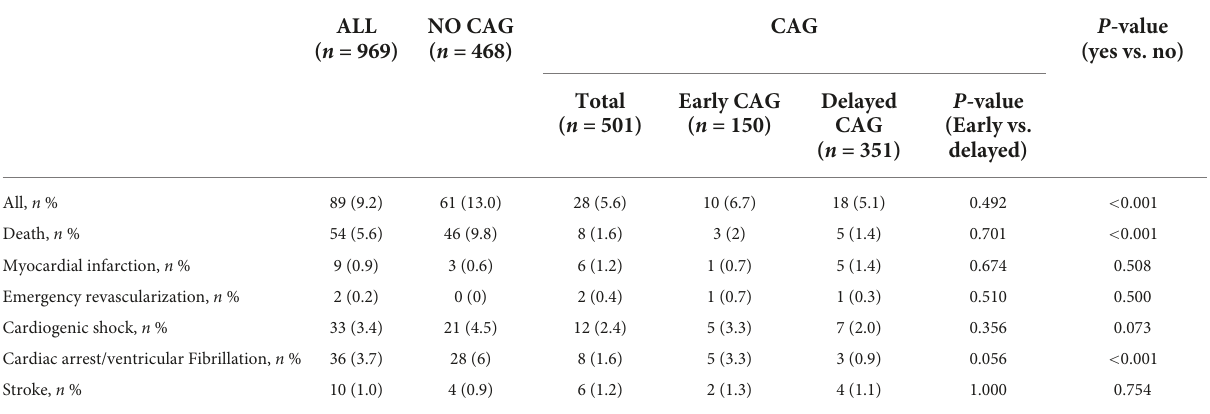
TABLE 3 30 days outcomes of patients with NSTEMI undergoing